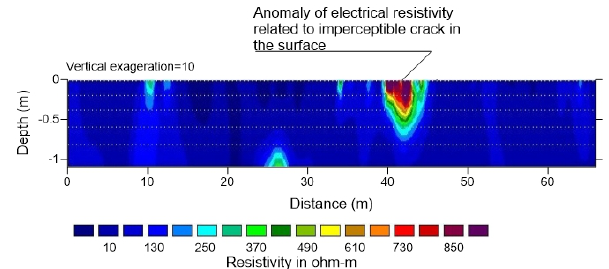
Figure 2. An example of resistivity anomaly related to a hidden or incipient surface fault surveyed in Aguascalientes City (After Pacheco-Martínez et al., 2013). Location of profile is shown in Fig.